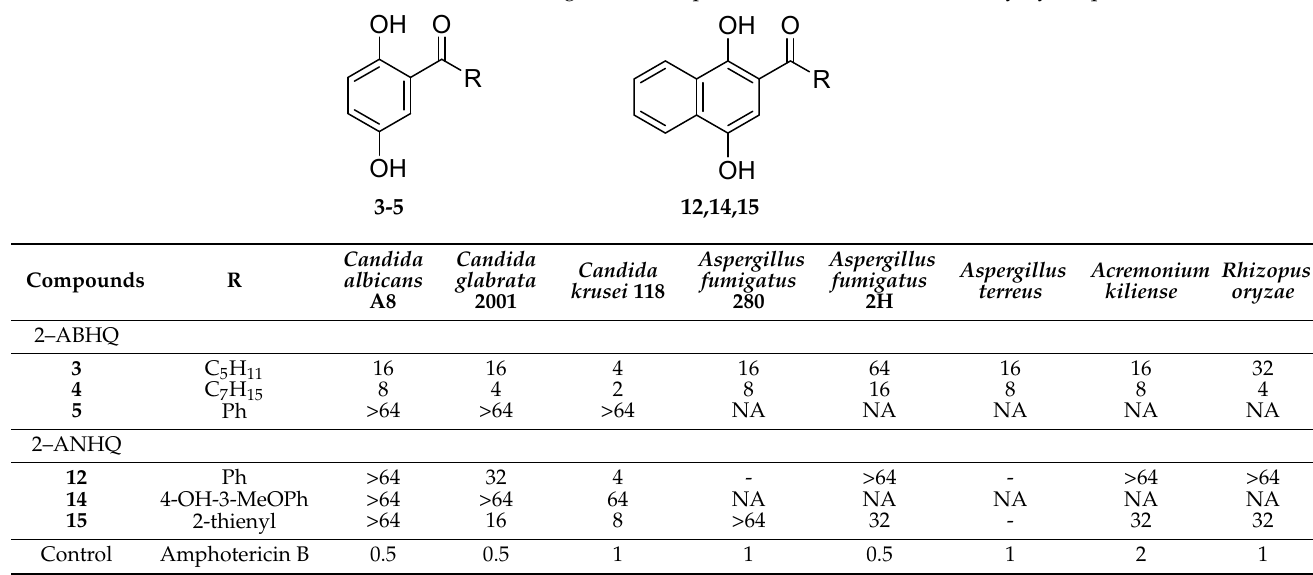
Table 2. MIC values ( μ g/mL) of amphotericin B and the selected acylhydroquinones.